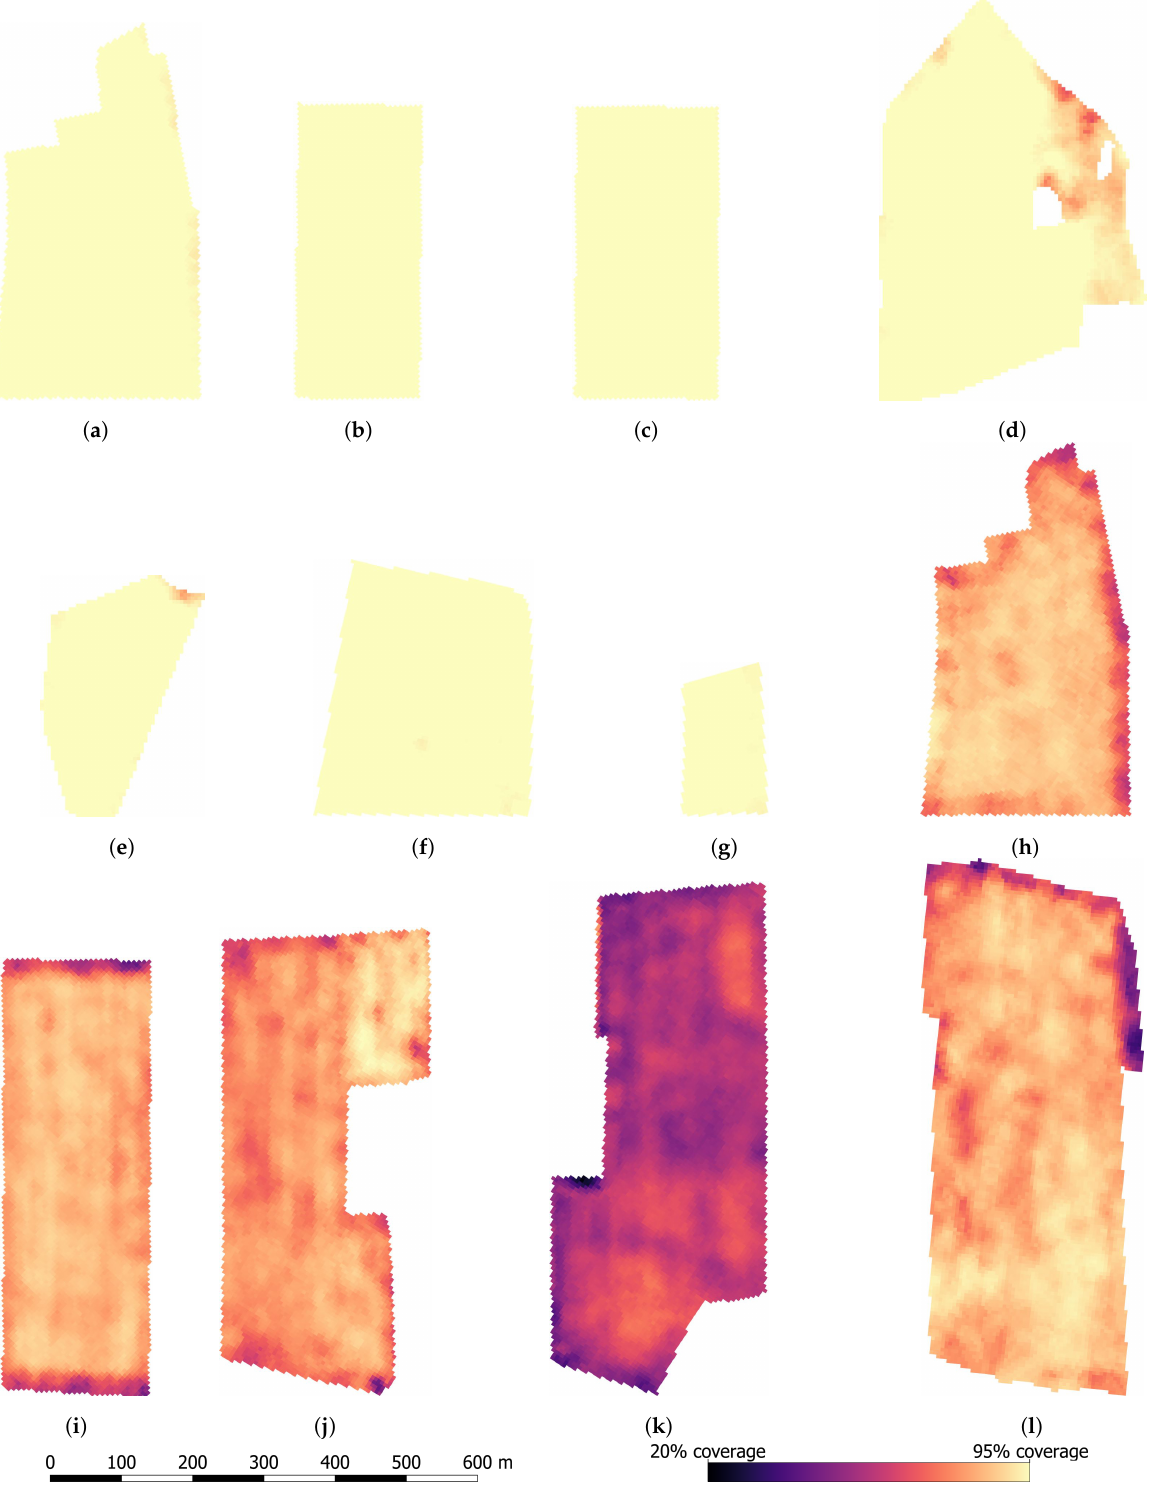
Figure 14. Visualization of the predicted canopy coverage in a subset of the large scale mapped fields. Fields ( a – g ) were sampled in May. Fields ( h – l ) were sampled in October. Each square unit represents a 5